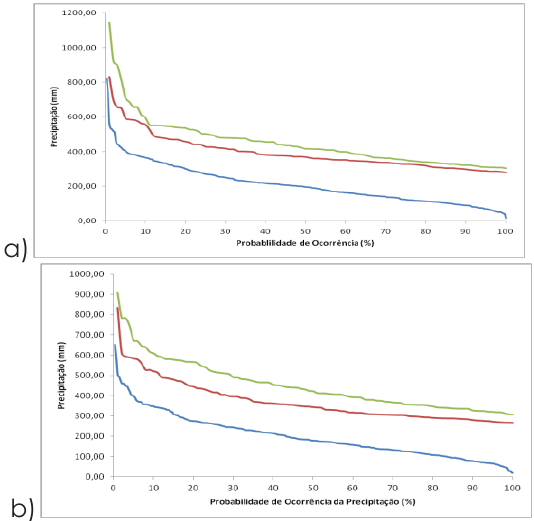
Figure 3. Permanence curve of precipitation projections for scenario 1 (blue line); Scenario 2 (red line); Scenario 3 (green line): a) Post 1 and b) Post 2